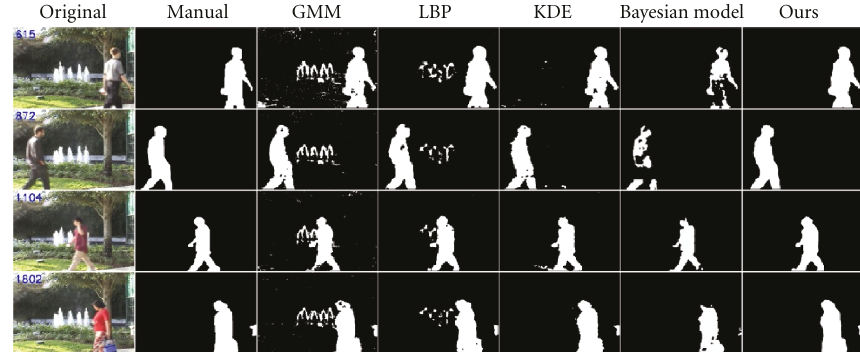
Figure 6: Qualitative comparison results of the five BGS algorithms on the Fountain sequence. The first column contains the original video frames. The second column contains the corresponding ground truth frames. The last five columns contain the detection results of the GMM, LBP, KDE, Bayesian Model and our method,